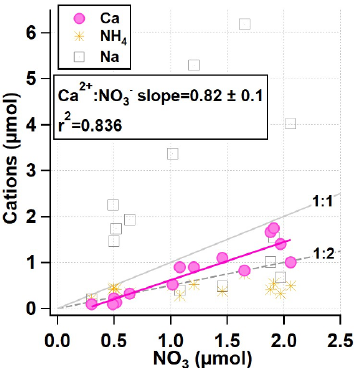
Figure 7. Daily total micromoles of NH 4 , Ca, and Na vs. NO 3 within the snow from 21 January to 3 February 2017, leading into the most severe PCAP period from 27 January to 4 February